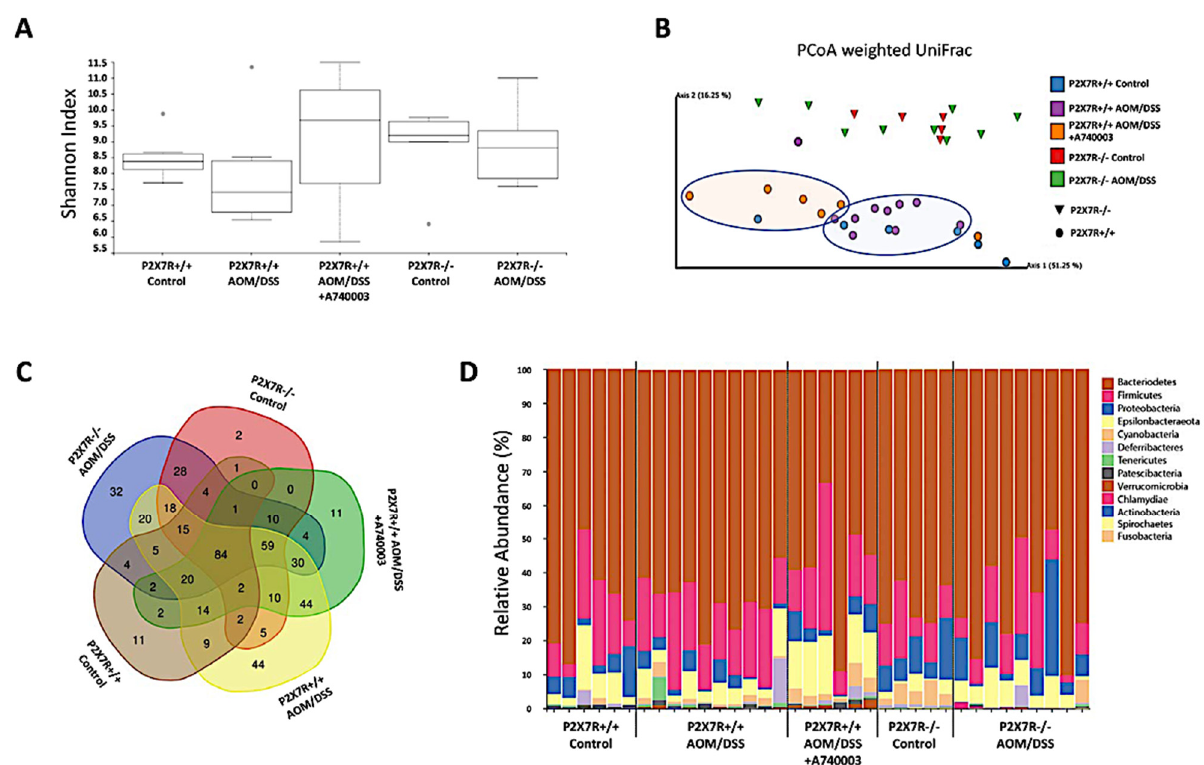
Figure 7. P2X7R blockade is followed by changes in the fecal microbial diversity and composition. Alpha-diversity analysis using the Shannon index shows an upward trend in fecal microbial diversity when P2X7R is blocked ( A ). Beta-diversity analysis using weighted UniFrac principal coordinate analysis (PCoA) clusters P2X7R − / − away from P2X7R +/+ samples ( B ). A Venn diagram displays the logical relations among groups ( C ). Differential abundance analysis of taxonomic profiles depicts the microbial composition at the phylum level ( D ). Sequencing was performed with samples from two independent experiments, with 2–5 animals per group.